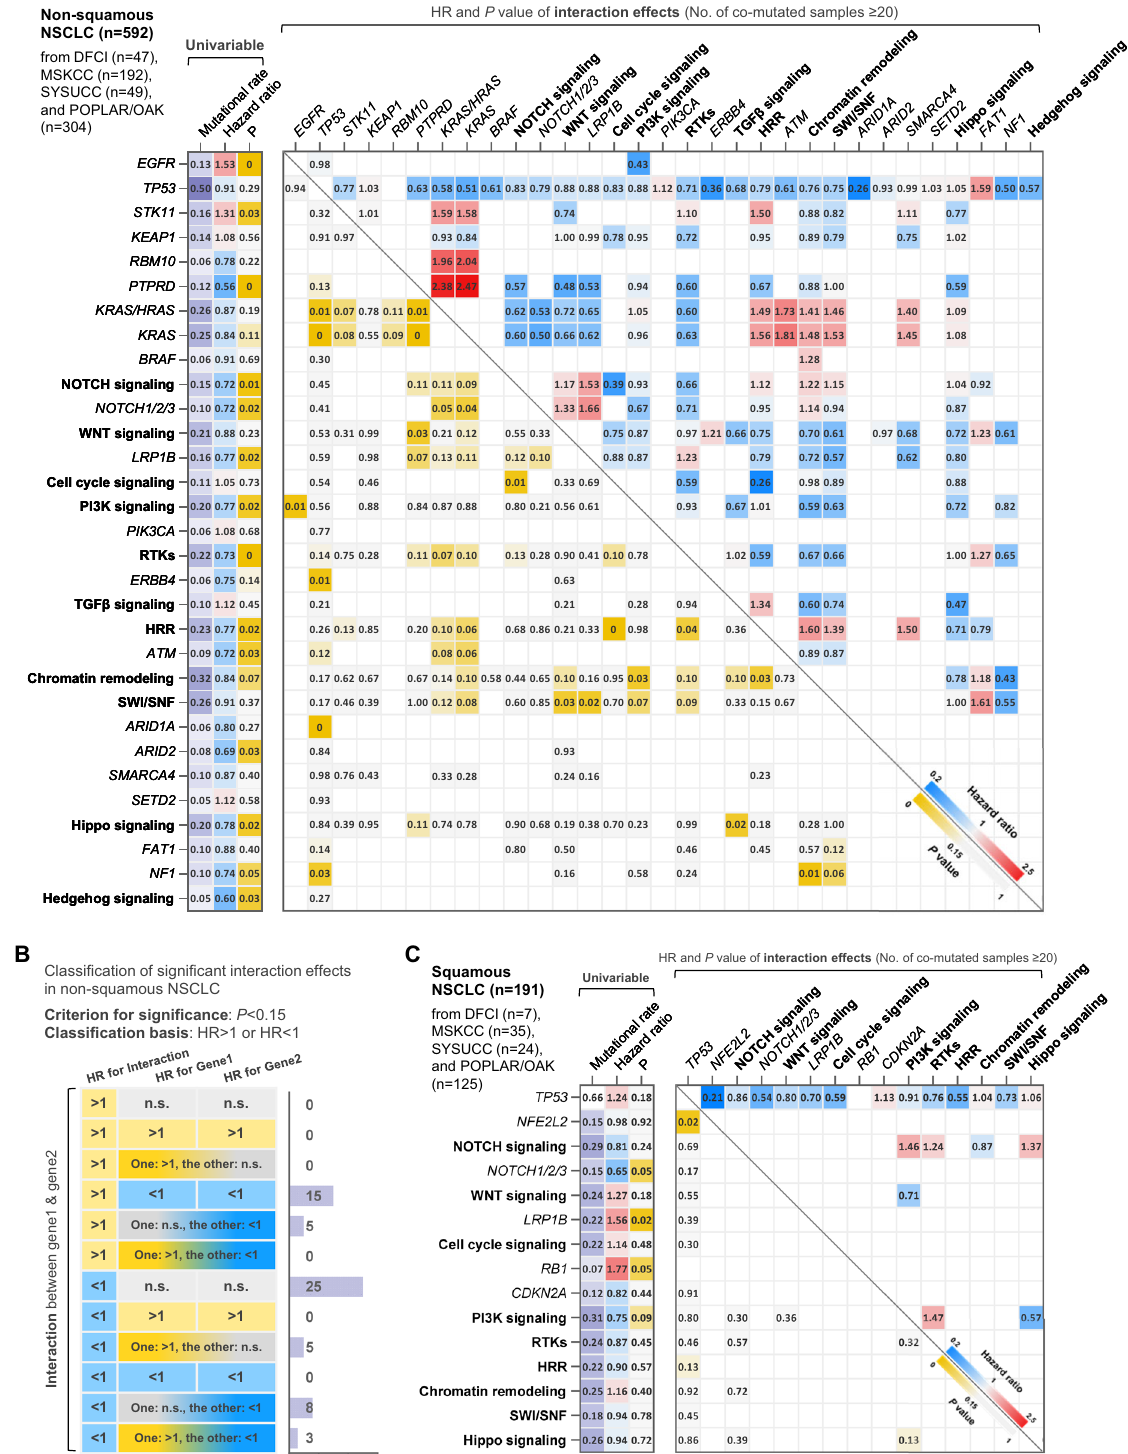
Fig. 1 Associations of ICI ef fi cacy with single mutations and interactions of co-occurring mutations in NSCLC. A Landscape of the predictive utilities of single mutations (left) and the interaction effects of common co-occurring mutations (right) in nonsquamous NSCLC. B Classi fi cation of interaction effects based on the effect sizes of single mutation terms and interaction terms. C Landscape of the predictive utilities of single mutations (left) and the interaction effects of common co-occurring mutations (right) in squamous NSCLC. Abbreviations: NSCLC nonsmall cell lung